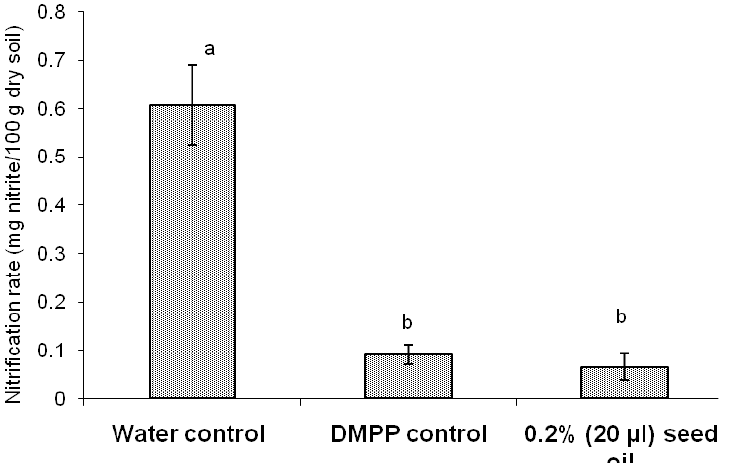
Fig. 1. Amount of nitrite produced under application of 20 µl seed oil (from A. totai ) compared to water control and DMPP control (10% of N-NH 4+ ) in 24 h incubation test. Each sample consisted of 2.5 g fresh soil+7.5 ml of 13.3 mM (NH distilled water or DMPP or seed oil. Comparison of means was done at 5% of Duncan test. Data are the averages of four replicates ± SD